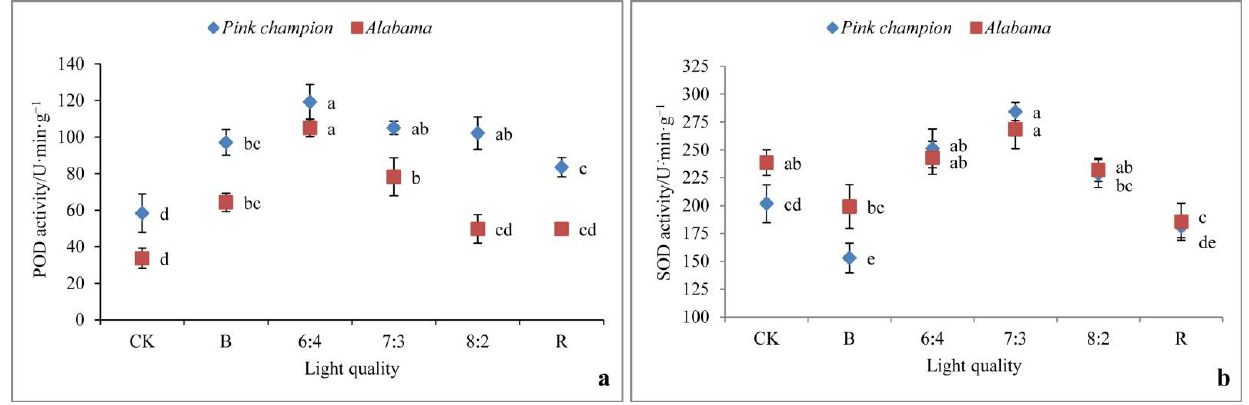
Figure 7. Effects of different light qualities on POD ( a ) and SOD ( b ) activity of Anthurium ‘Pink Champion, Alabama’. The statistical analysis has been carried out separately for each cultivar. Vertical bars indicate standard error ( n = 5). Different letters represent a significant difference at p < 0.05 among treatments by the Duncan’s multiple range